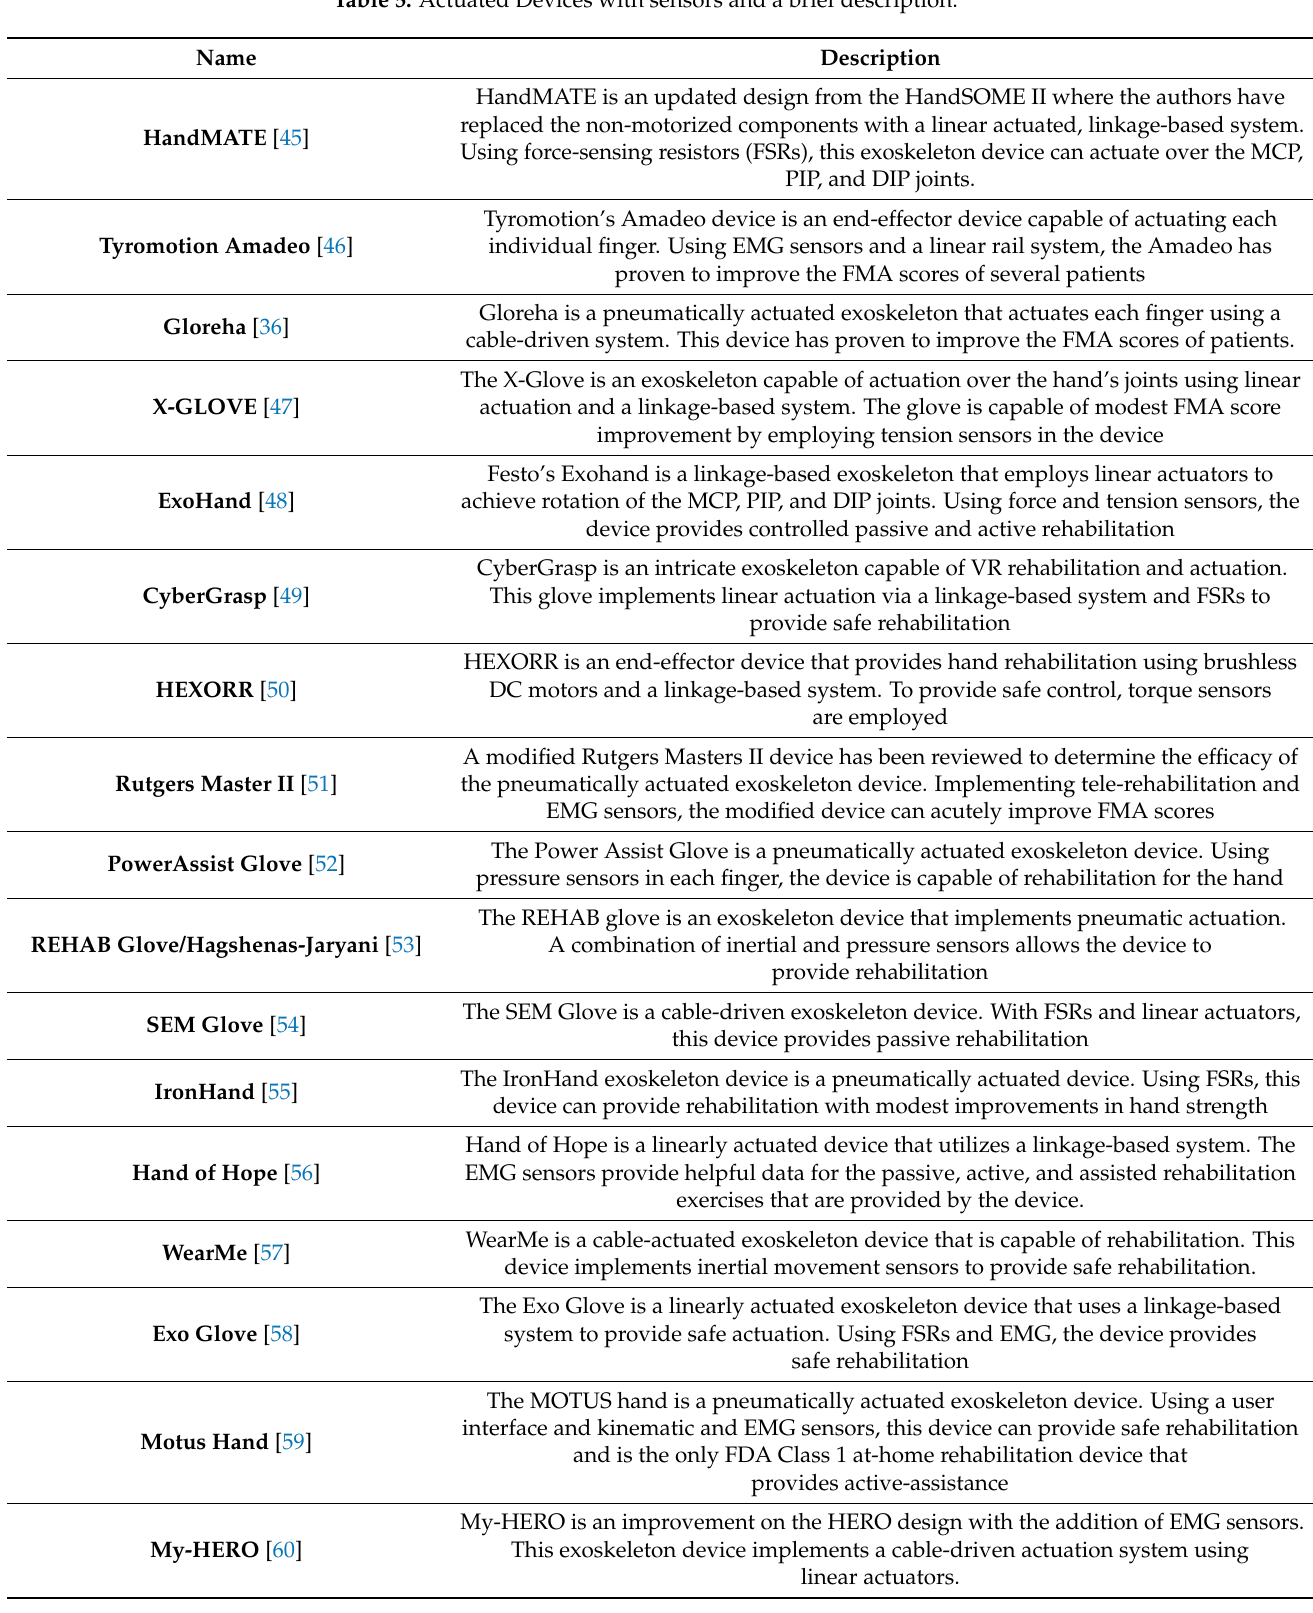
Table 5. Actuated Devices with sensors and a brief